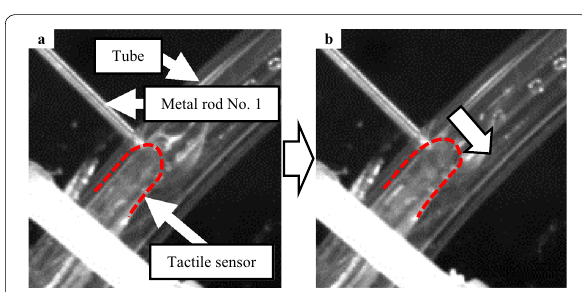
Fig. 12 Deflection of prototype sensor in blood vessel model No. 1 on contact with a protrusion. a Before bending. b After